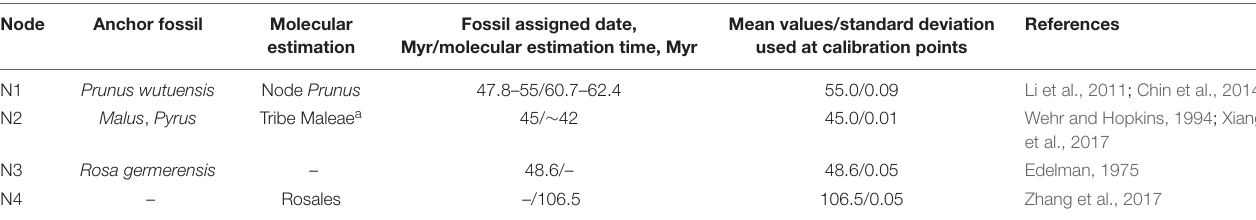
TABLE 1 | Fossils and molecular estimation used as calibration points for molecular dating. Node Anchor